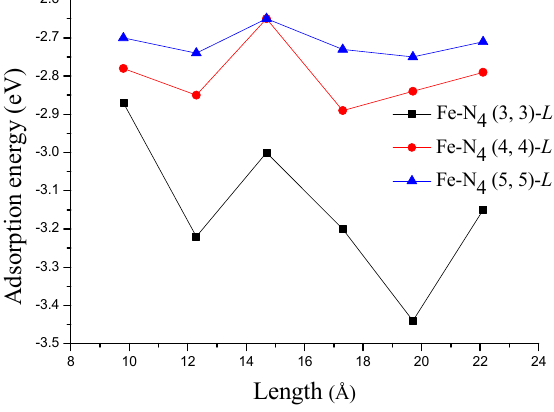
Figure 5. Calculated adsorption energies of OH with the increasing of tube length.